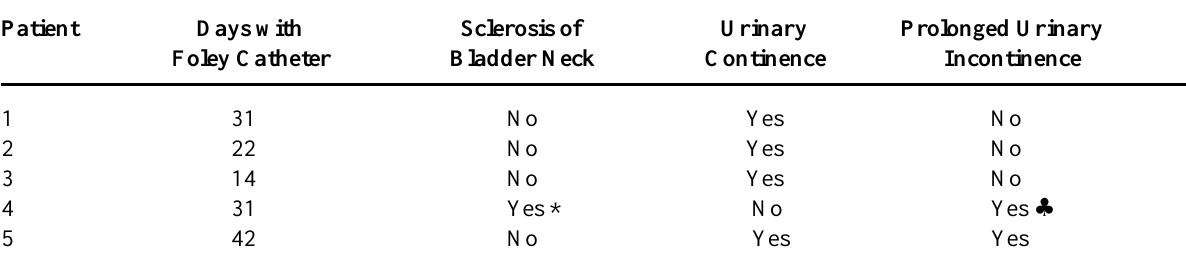
Table 2 - Period with vesical catheter and